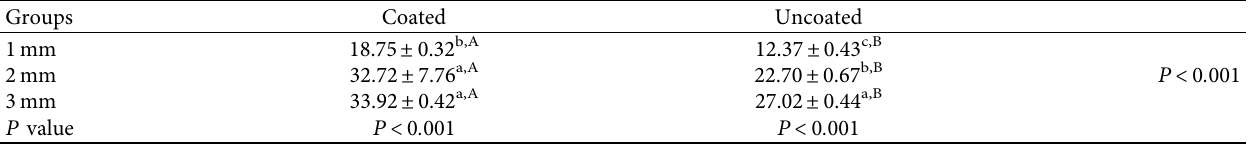
Table 1: Mean ± SD of three-point bending strength values ( N ) in coated and uncoated wires.